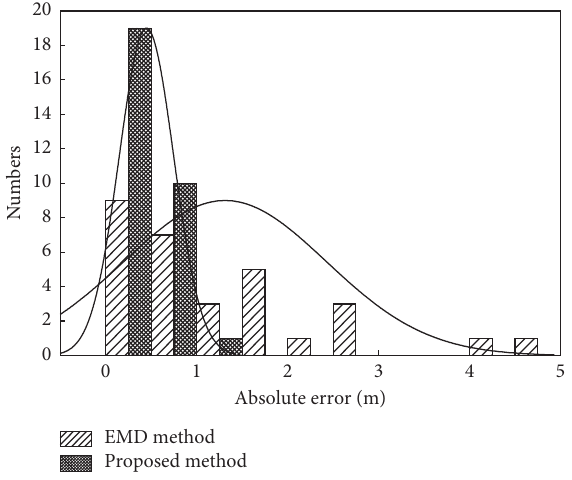
Figure 11: Pipe absolute positioning error.